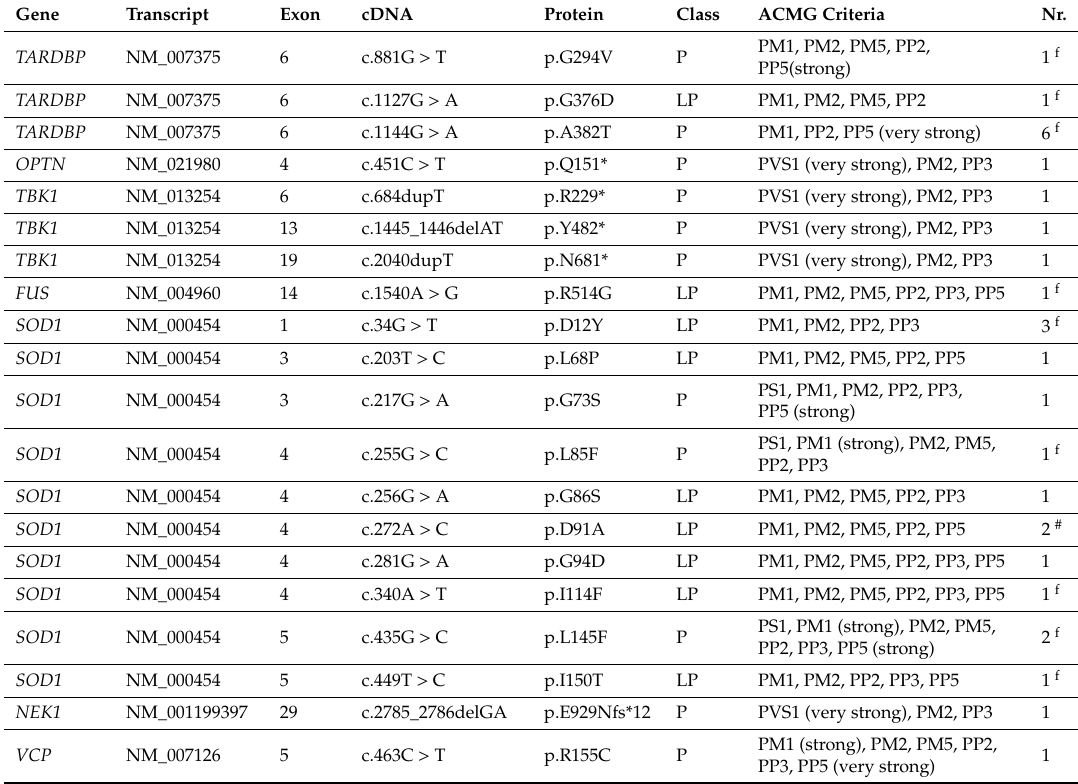
Table 2. List of pathogenic or likely pathogenic variants identified.